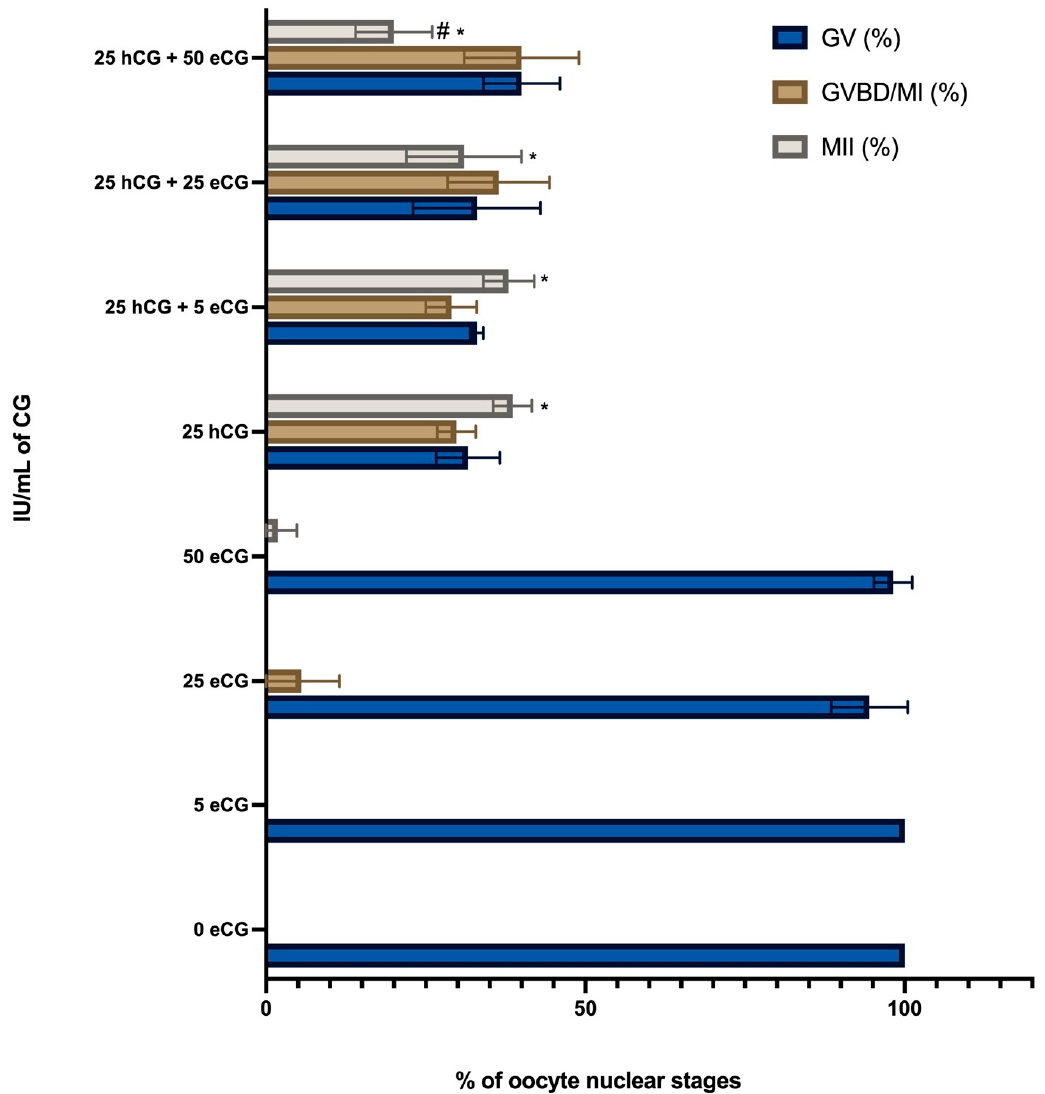
Figure 5. Influence of eCG stimulation of FEO on oocyte meiotic resumption. The experiments were performed by exposing EA-FEO to increasing doses of eCG (0, 5, 25, 50 IU/mL) in the absence or presence of hCG (25 IU/mL). Three independent biological replicates were performed for each experimental group (total number of oocytes analyzed: 95, 95, 100, and 94 respectively for 0, 5, 25, and 50 IU/mL eCG and 99, 101, 101, and 94, respectively, for 25 IU/mL hCG, 25 hCG +5 eCG, 25 hCG +25 eCG, 25 hCG + 50 eCG IU/mL). The significance of each nuclear stage data (GV, GVBD/MI, or MII) collected in dose-response eCG stimulation was statistically analyzed vs. 0 eCG indicated with (*) superscript when p < 0.05. The significance of each nuclear stage data (GV, GVBD/MI, or MII) collected in dose-response eCG stimulation in the presence of 25 IU/mL hCG was statistically analyzed vs. 0 eCG + 25 hCG indicated with (#) superscript when p <